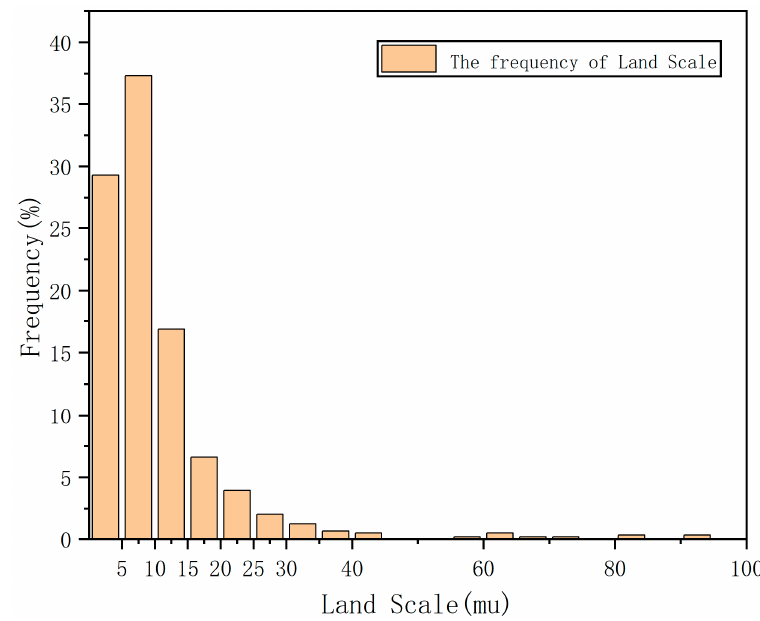
Figure 3. Distribution of the agricultural land scale.